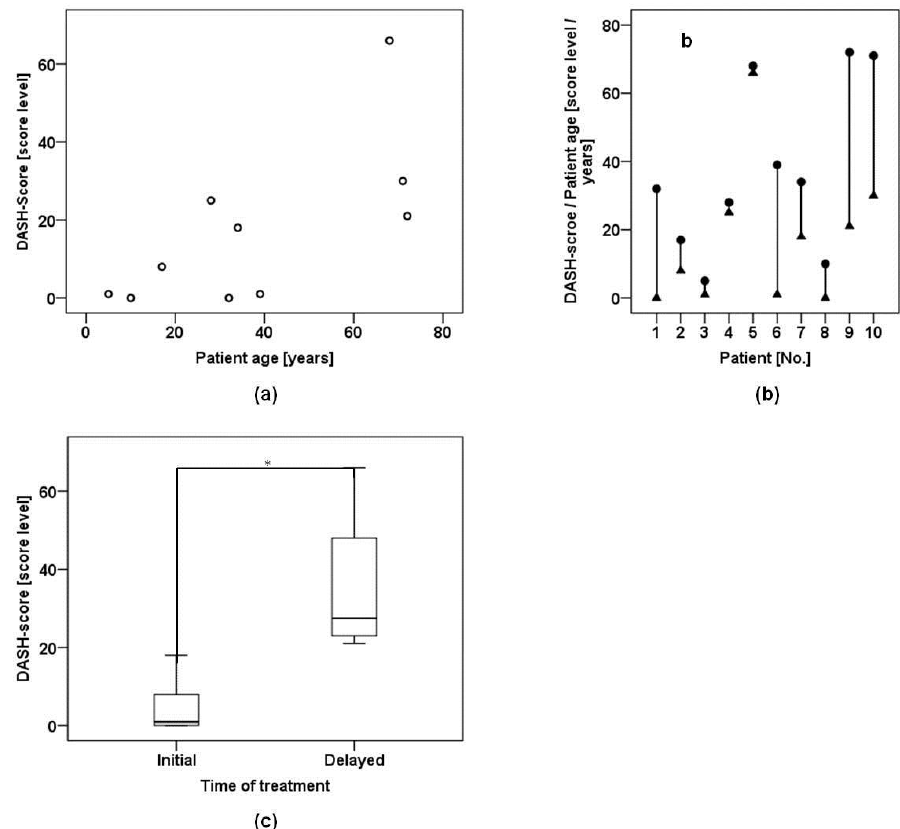
Figure 2. Confounding variables for the functional outcome after nerve injuries: ( a ) There was a positive correlation between patient age and DASH results, notwithstanding that this correlation was not statistically significant; ( b ) Plot shows DASH score level (triangles) and corresponding age (dots) of each patient. Younger patients tended to have lower DASH score levels; ( c ) Box plot represents DASH score results of patients who received either initial treatment or delayed treatment. Initial treatment resulted in better DASH score levels. This difference proved to be significant (*).